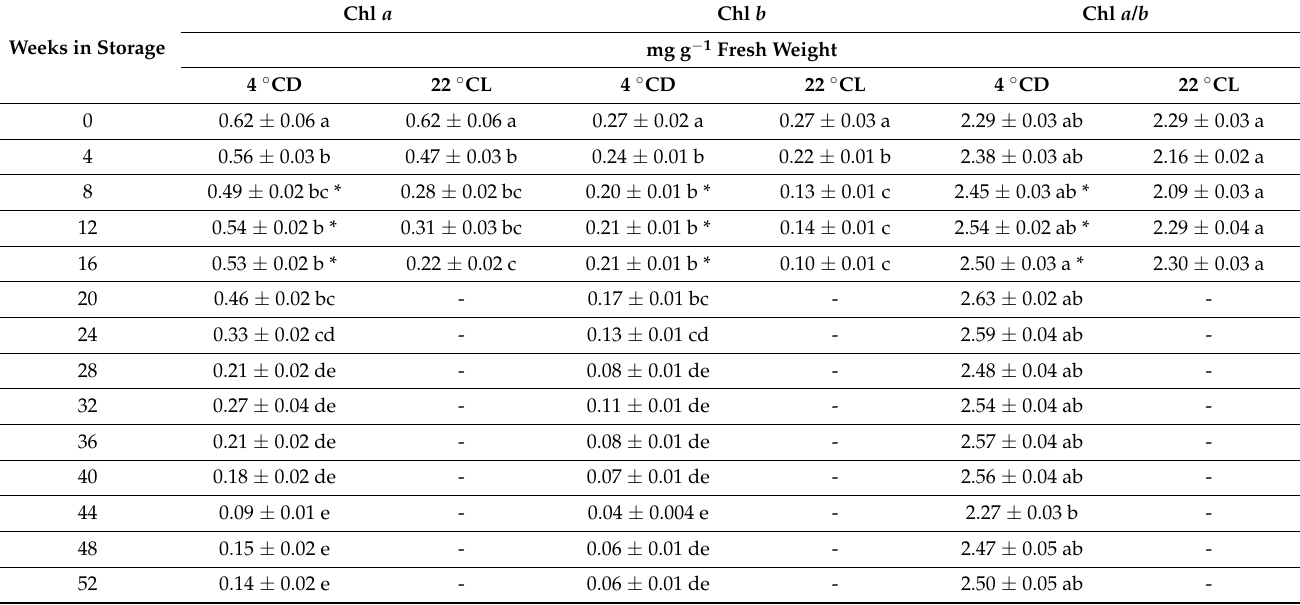
Table 2. Chlorophyll content (Chl a , Chl b , and Chl a / b ) in the in vitro leaves of S. redliana ‘Burokvölgy’ under storage conditions of 4 ◦ CD and 22 ◦ CL. Values are expressed as the mean ± SE of chlorophyll content. Lower case indicates the significant differences between the chlorophyll content measured after different storage times. * indicates the significant differences between the chlorophyll content of leaves from different storage